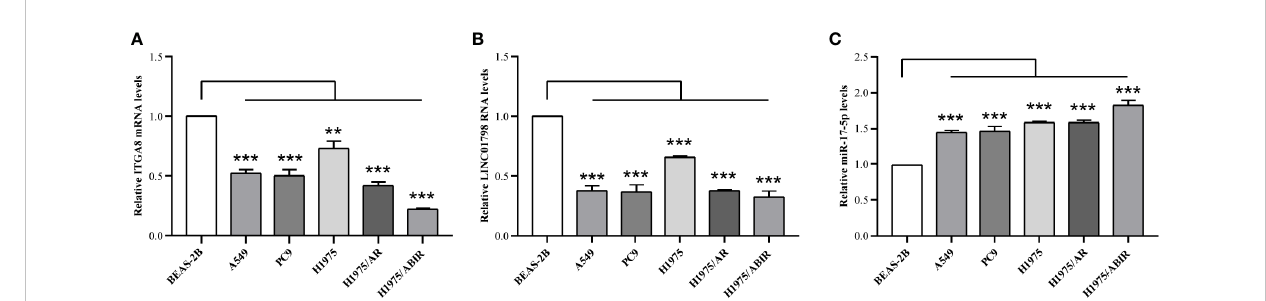
FIGURE 7 LINC01798, miR-17-5p, and ITGA8 expression in 5 LUAD cell lines and 1 human bronchial epithelial cell line as determined by qRT-PCR. Expressions of (A) ITGA8, (B) LINC01798, and (C) miR-17-5p in LUAD cell lines (A549, PC9, H1975, H1975/AR, and H1975/ABIR) and a human bronchial epithelial cell line (BEAS-2B) are analyzed by qRT-PCR. ** p < 0.01, *** p <